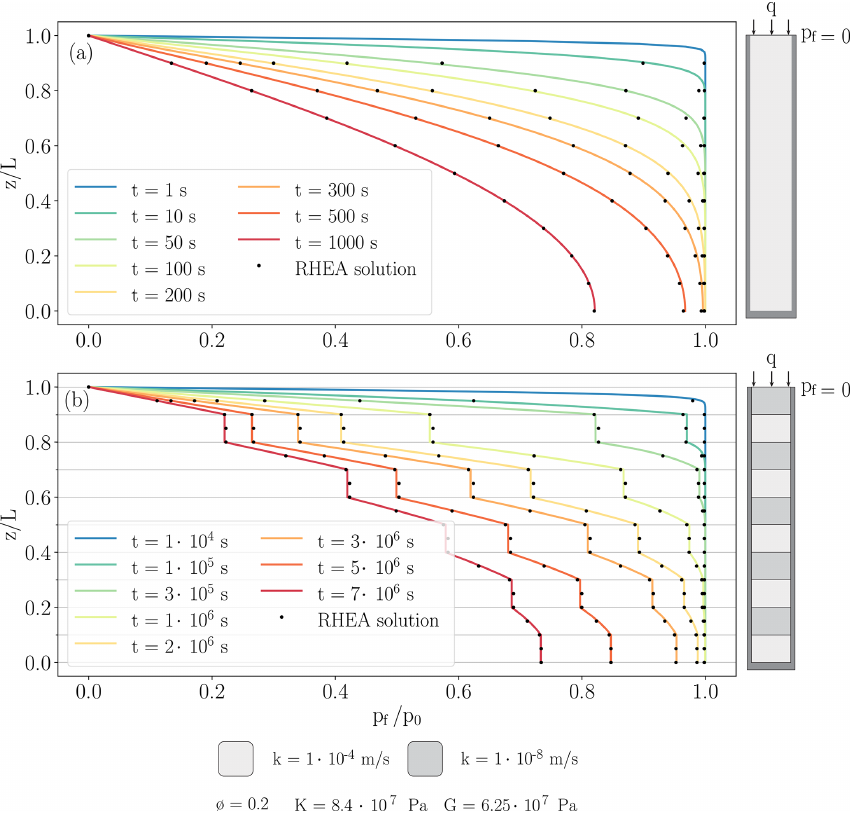
Figure 2. The lines represent the analytical solution whereas the dots represent the RHEA solution. (a) Homogeneous case. For this simula- tion, a total of 100 nodes and 99 elements were set. (b) Heterogeneous case. For this simulation, a total of 100 nodes and 99 elements were